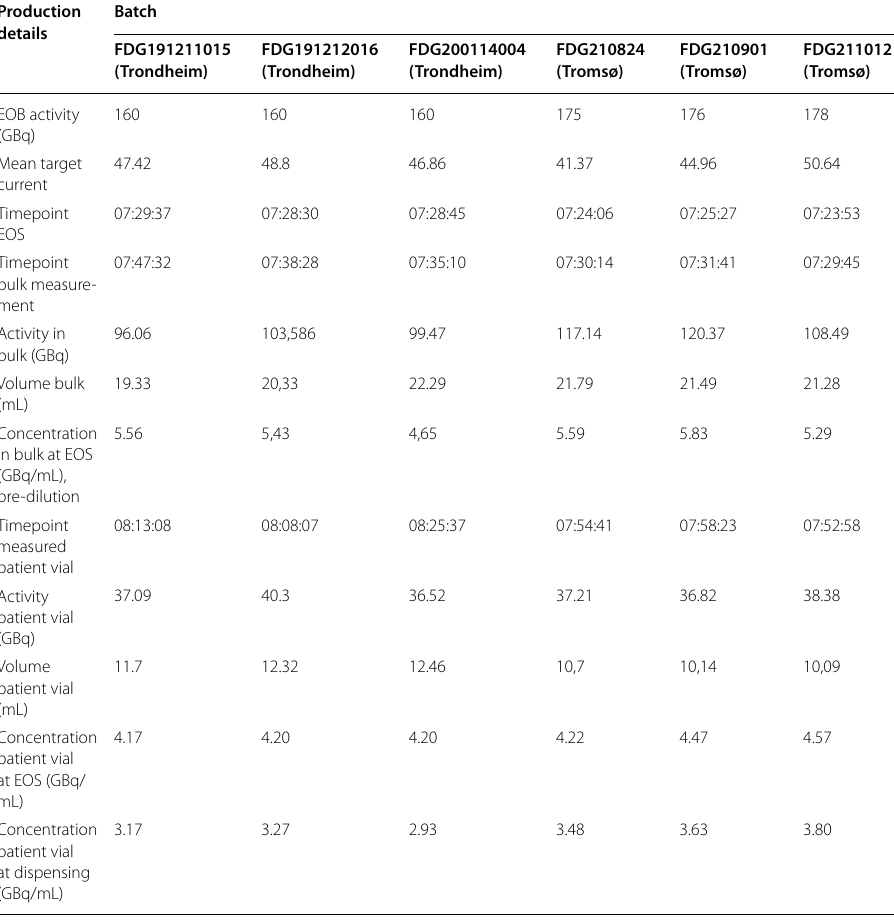
Table 1 Production details from the PET-centers in Trondheim and Tromsø Production Batch details